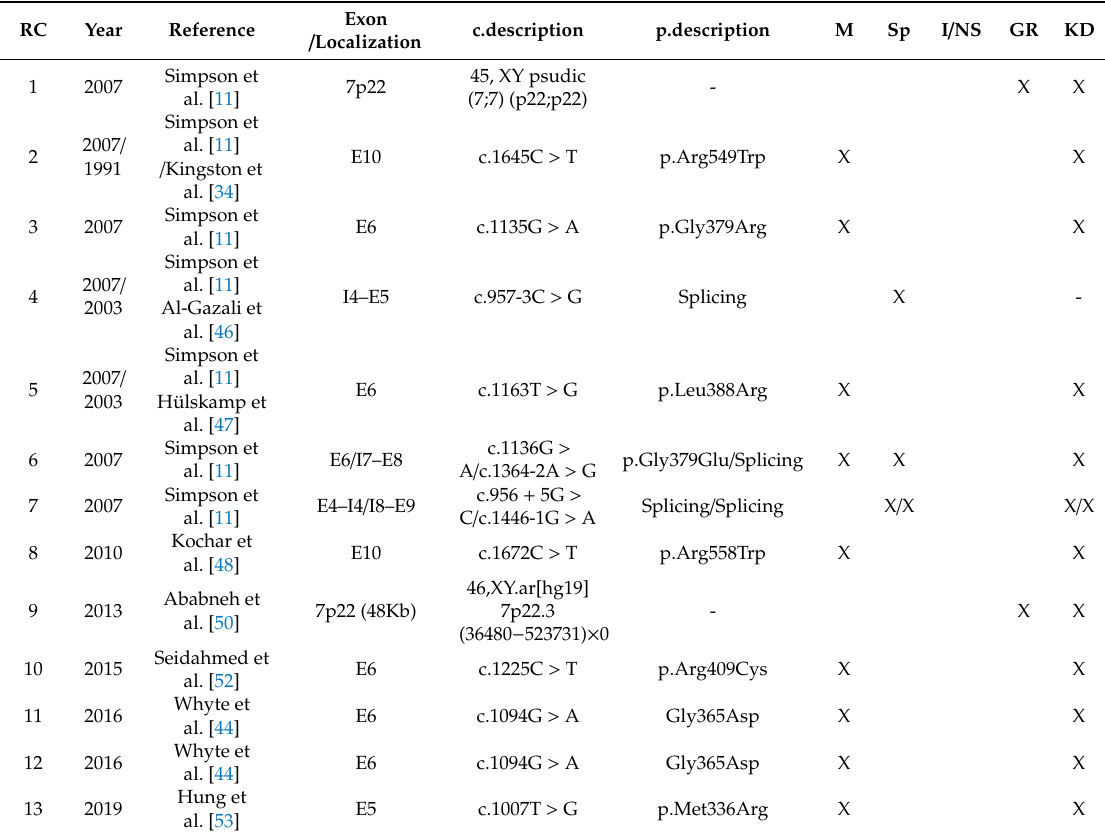
Table 1. FAM20C variants related to lethal Raine